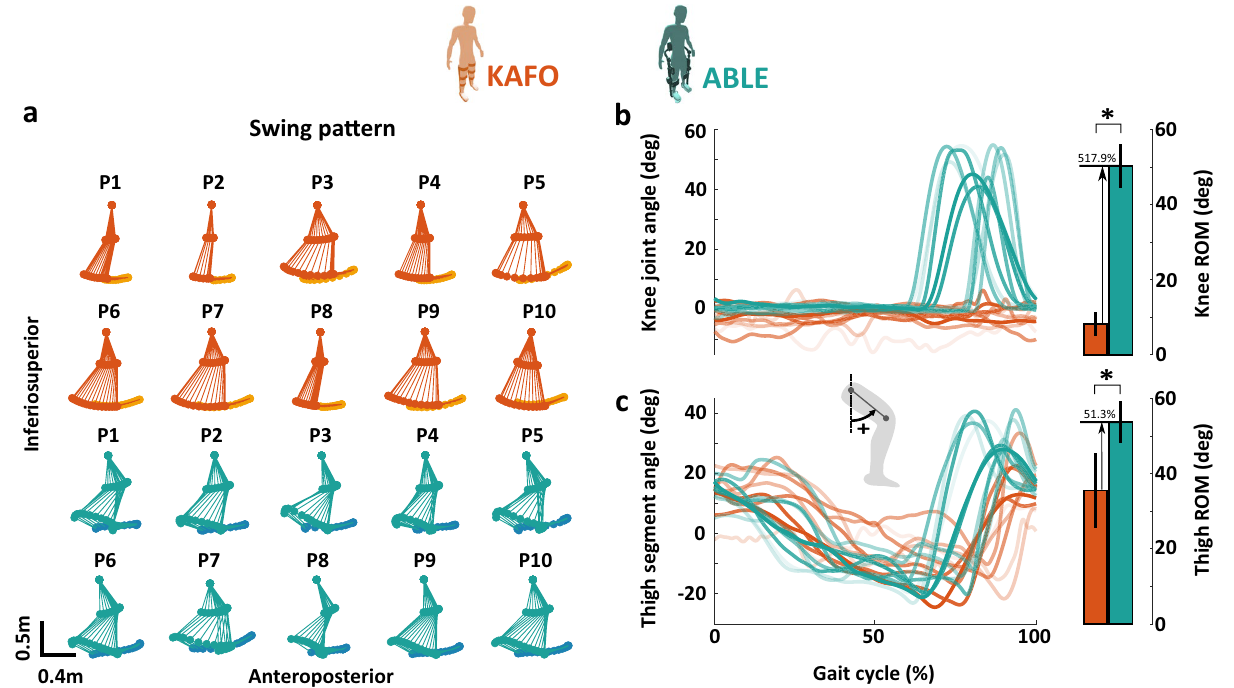
Figure 3. ( a ) Average swing pattern of the leg in the sagittal plane of each participant and device during the 6 MWT. The toe marker is shown with a different color (KAFO: light orange, ABLE: blue). ( b ) Representative knee flexion/extension angle of each participant during the gait cycle, and a bar plot showing the average and standard deviation from all the participants’ ROM. ( c ) Representative thigh segment angle in sagittal plane of each participant during the gait cycle, and a bar plot showing the average and standard deviation from all the participants’ ROM. The knee joint and thigh segment angles were measured during the 6 MWT. Stars (*) indicate statistically significant differences ( p < 0.05